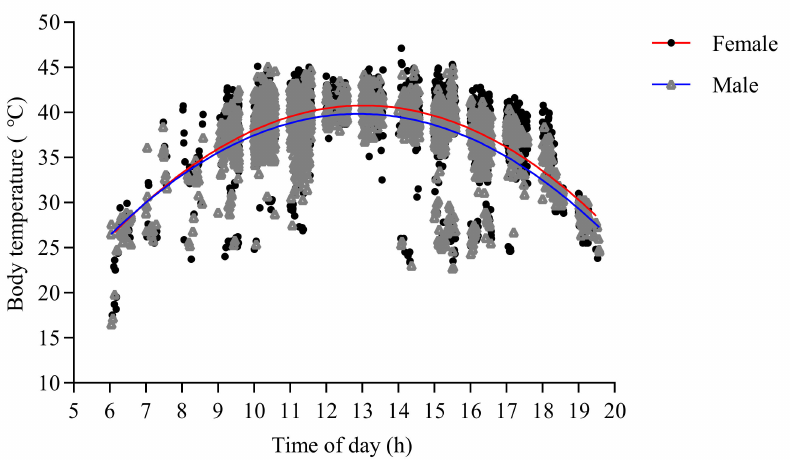
Figure 3. Daytime changes in the internal body temperatures of female and male Oedaleus decorus asiaticus specimens from eight different